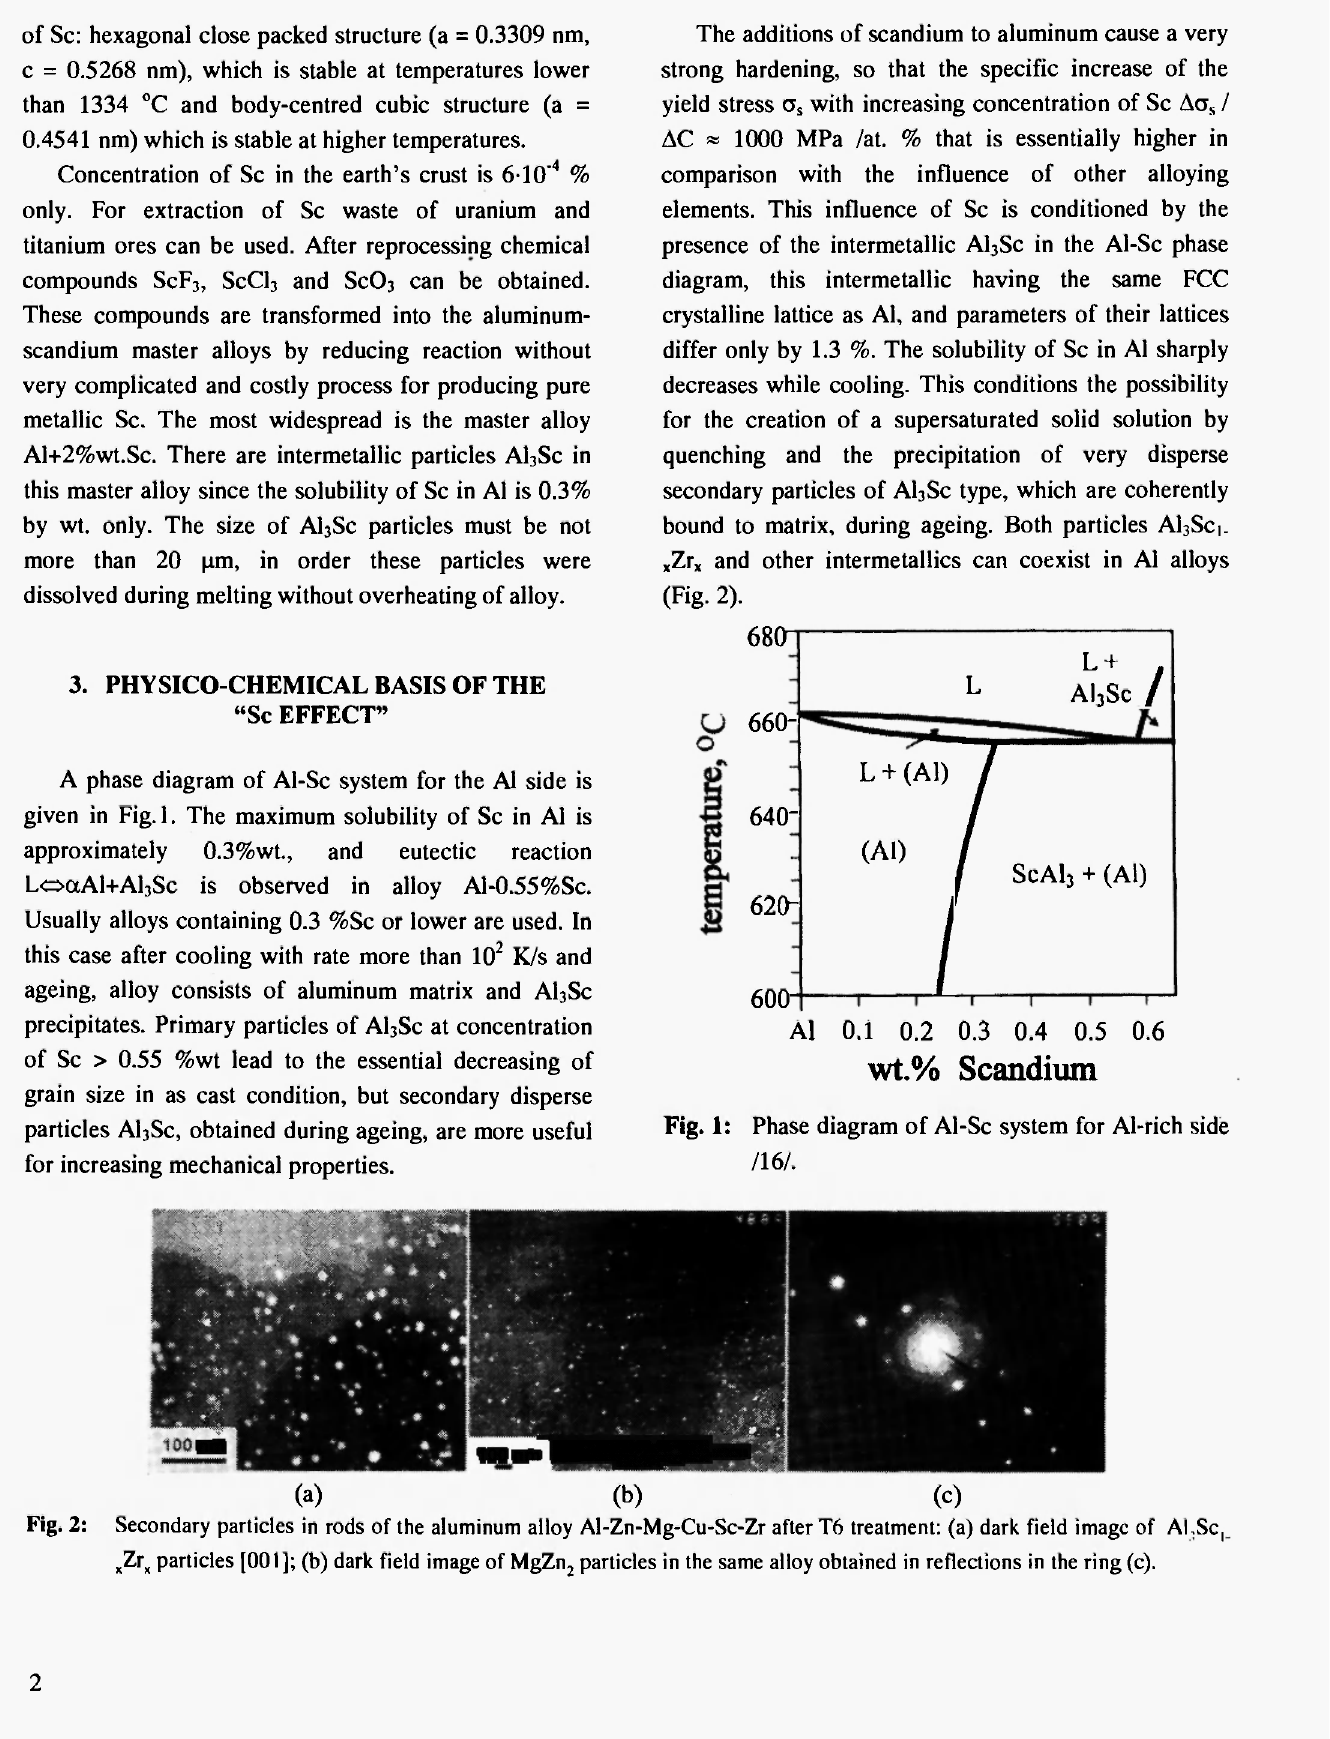
Secondary particles in rods of the aluminum alloy Al-Zn-Mg-Cu-Sc-Zr after T6 treatment: (a) dark field image of Al,Sc, x Zr x particles [001]; (b) dark field image of MgZn 2 particles in the same alloy obtained in reflections in the ring